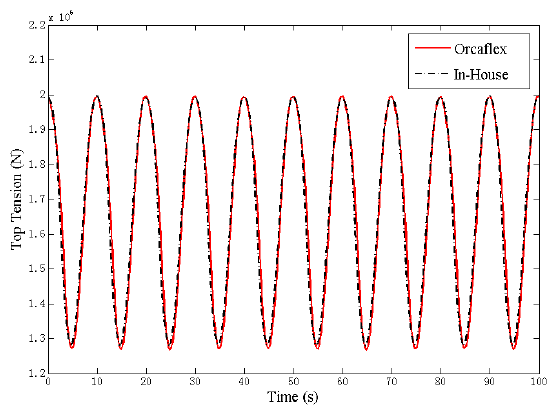
Figure 6. Single mooring line under vertical harmonic excitation with wave and current.